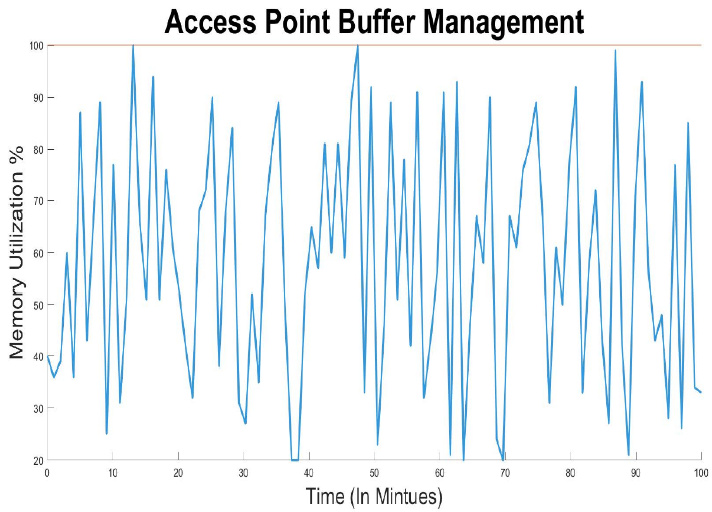
Figure 16. Access Point buffer memory utilization with time.